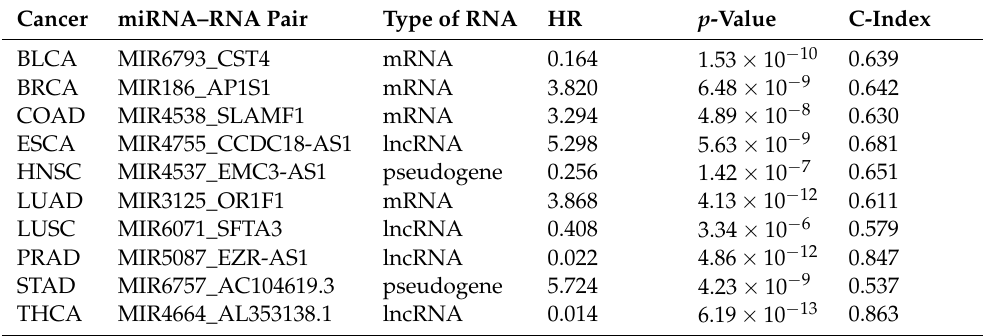
Table 5. The results of univariate Cox regression analysis with respect to miRNA–RNA pairs with the lowest p -value in the log–rank test. HR: hazard ratio.